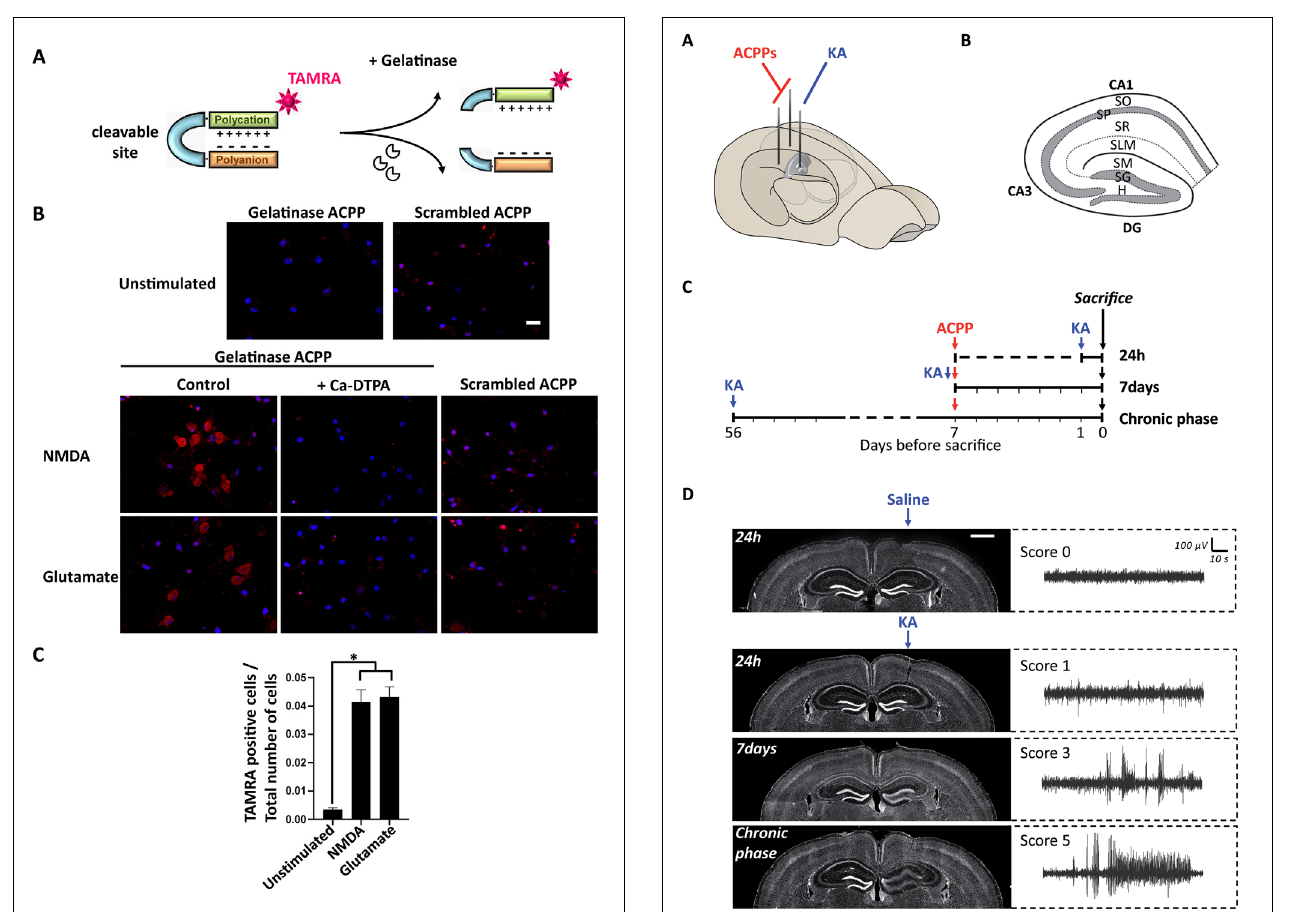
FIGURE 3 | Experimental protocol of ACPPs injection in a mouse model of epileptogenesis. (A) Scheme of kainic acid (KA) and ACPPs injections in hippocampal hemispheres. (B) Scheme of hippocampal structure and lamination. CA, cornu ammonis; DG, dentate gyrus; H, hilus; SO, stratum oriens; SP, stratum pyramidale; SR, stratum radiatum; SLM, stratum lacunosum-moleculare; SM, stratum moleculare; SG, stratum granulosum. (C) Experimental procedure: timeline of injections. (D) Hoechst labeled nuclei showing progressive dentate gyrus cell dispersion in KA injected hippocampus, characteristic of epileptogenesis (scale bar: 1 mm). Corresponding EEG recordings representative of the different severity scores are shown on the right. Score 0: normal activity; score 1: low-voltage background activity; score 3: short discharges; score 5: recurrent seizures. KA injection, Figures 4F,M ), red fluorescence stained cells in the diffuse CA1 and the expanded granular cell layer. In the contralateral side, ACPPs localized in CA1 areas 24 h and 7 days after KA injection and in a sparse punctiform staining in the chronic phase. Vessels in stratum lacunosum moleculare were also stained. Differences between saline ( Figures 4A–C,M ) and KA injections ( Figures 4D–F,M ) were detected. In saline- injected mice, contralateral sites exhibit almost no TAMRA fluorescence. In contrary, ipsilateral injection shows a uniform sparse punctiform staining in the whole hippocampus. This staining, which may reflect a basal gelatinase activation due to inflammation caused by the injection itself, is more